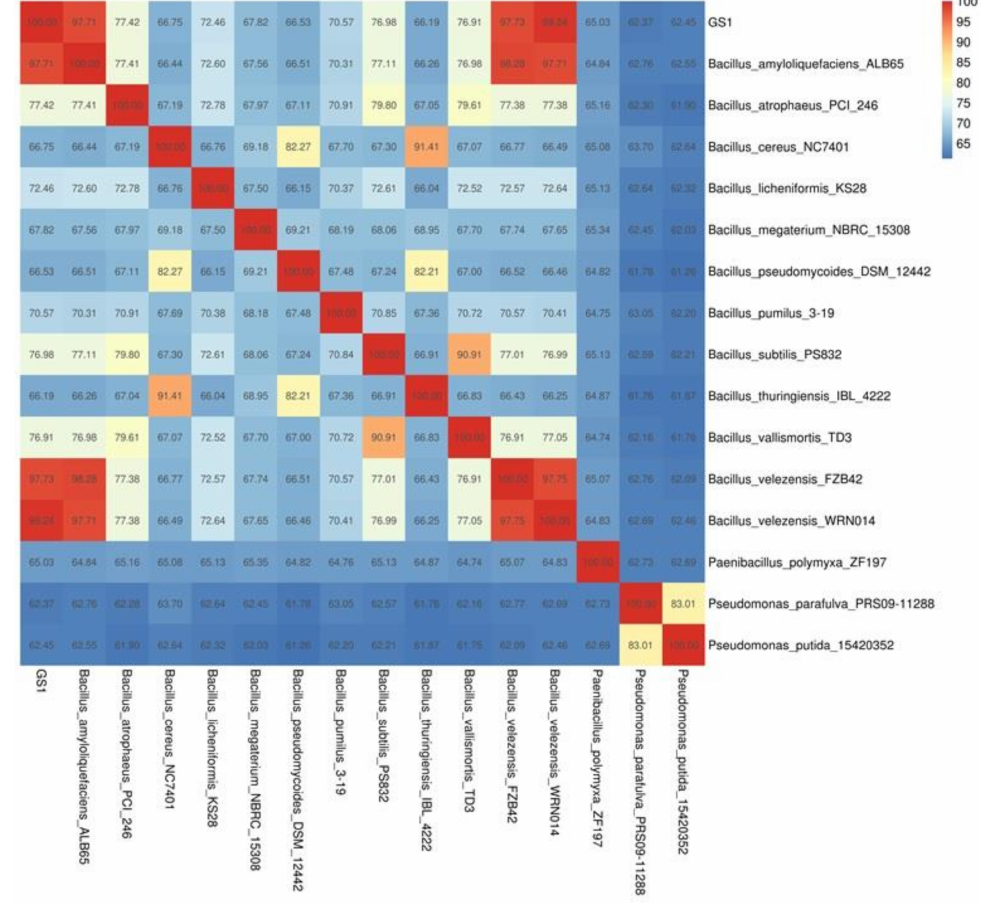
Figure 4. Heatmap of pairwise average nucleotide identity (ANI) values for whole genomes of GS-1 and 15 other Bacillus